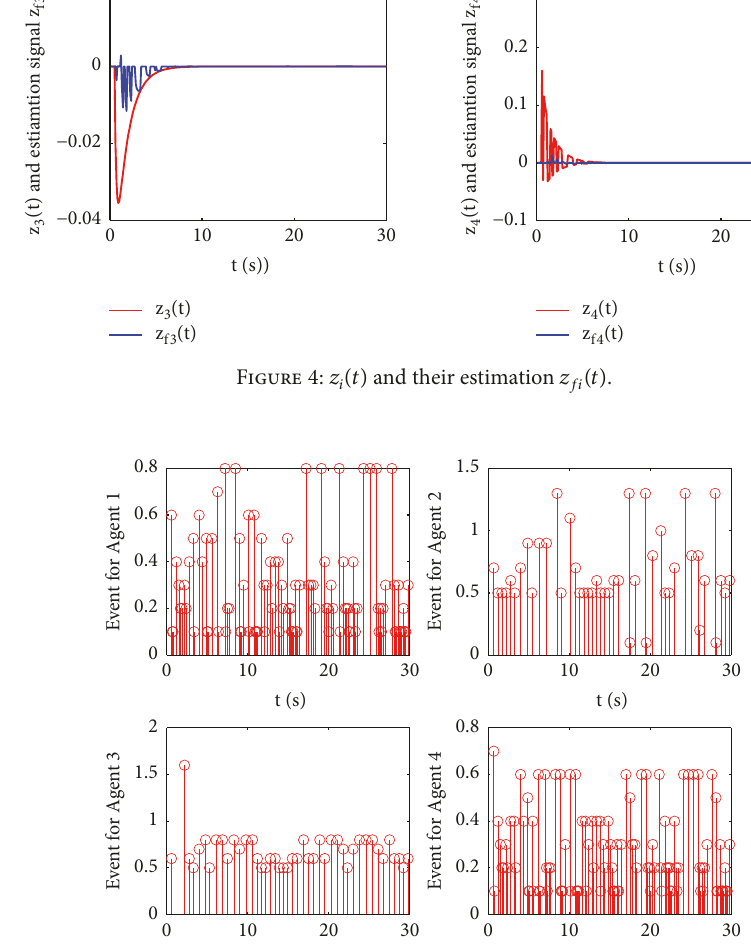
Figure 5: The release instants and release interval of each